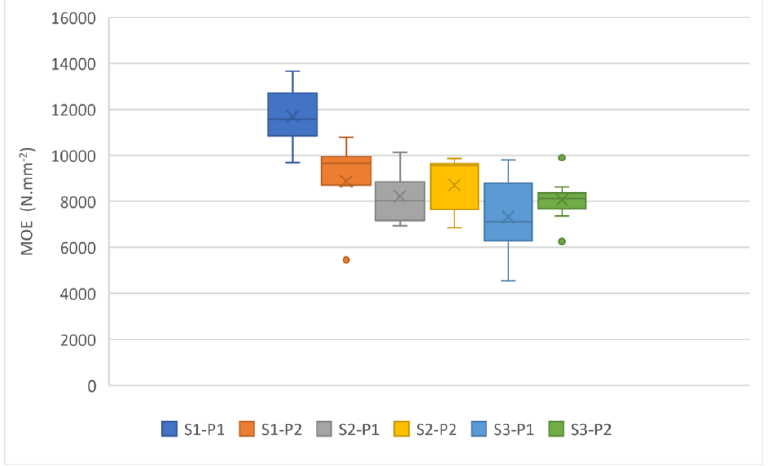
Figure 5. MOE at sites 1, 2, 3 and both distances to the pith (P1 — 10%; P2 — 90%).